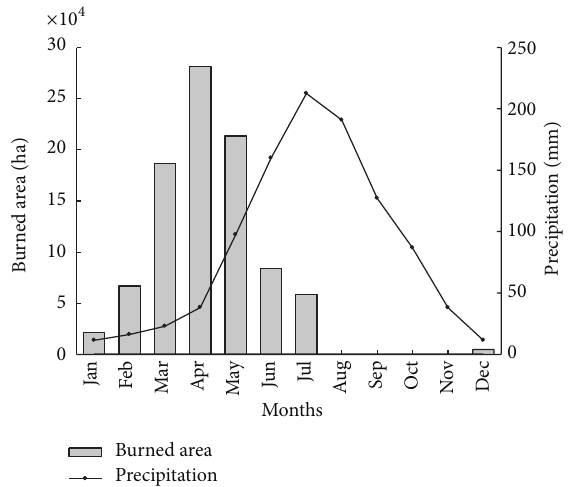
Figure 2: The mean annual burned area (ha) and precipitation (mm) during 1996–2008 by month in Yunnan province.